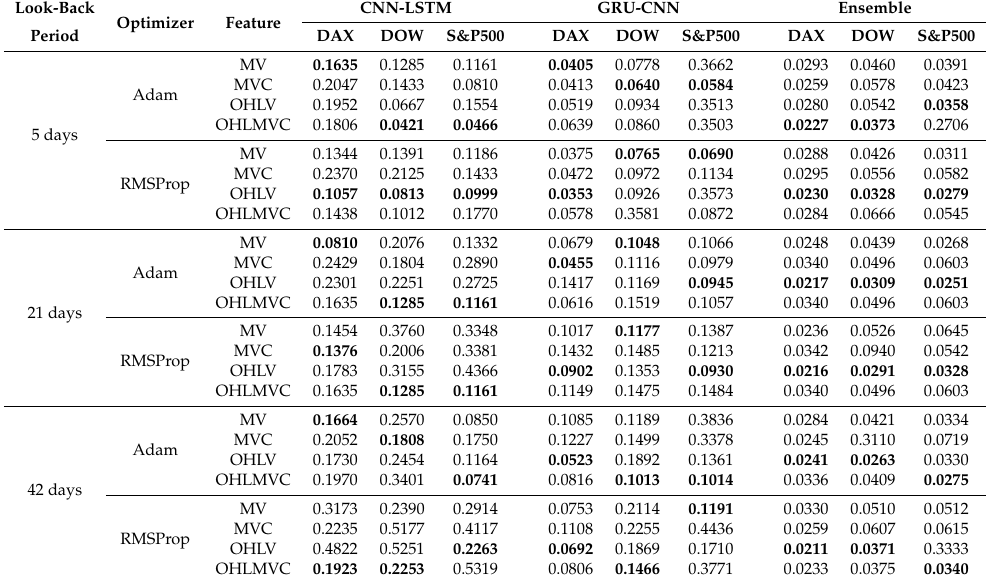
Table 5. Comparison of different optimizers and features in terms of average MAE over the three periods for one-time-step prediction.